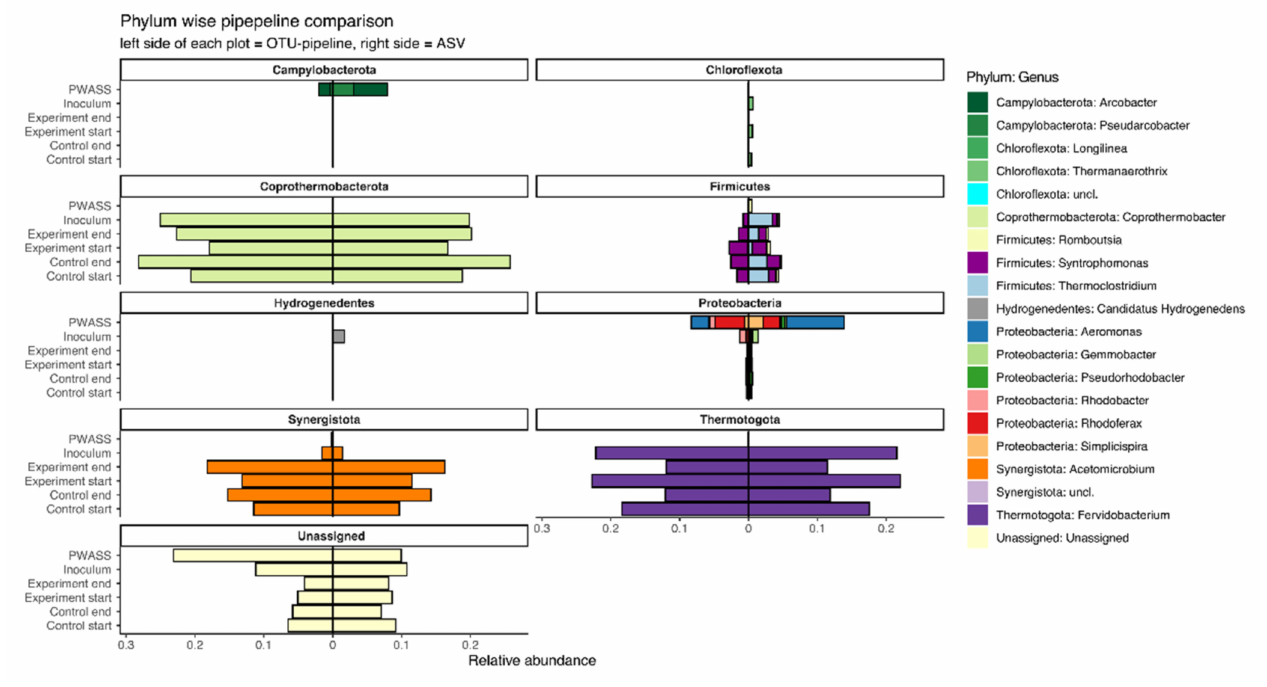
Figure 3. Divergence bar plot showing samples from the inoculum, representative lab-scale reactors, and the PWASS. Plotted are the taxa agglomerated at Genus level with the top 20 Permanova coeffi- cients identified as a response to the pipeline as a categorical factor. Bars are plotted Phylum -wise, with bars extending from the centerline to the left representing the relative abundance of the respec- tive taxon in the VSEARCH-based OTU pipeline, and bars extending to the right representing the ASV-generating DADA2-pipeline. Table 3. Simplified Permanova analysis